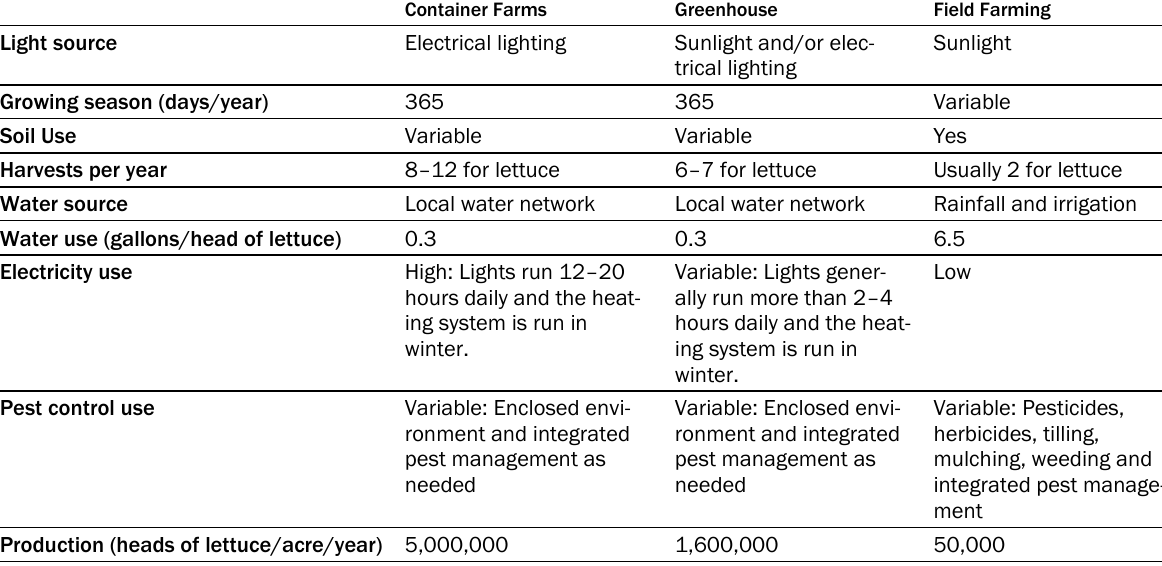
Table 1. Comparison of Containerized Food Production Systems (CFPS) Using Hydroponics, Greenhouse, and Field Farming Presenting both CFPS and greenhouses demonstrates the differences that can exist between various c ontrolled environment agriculture (CEA)